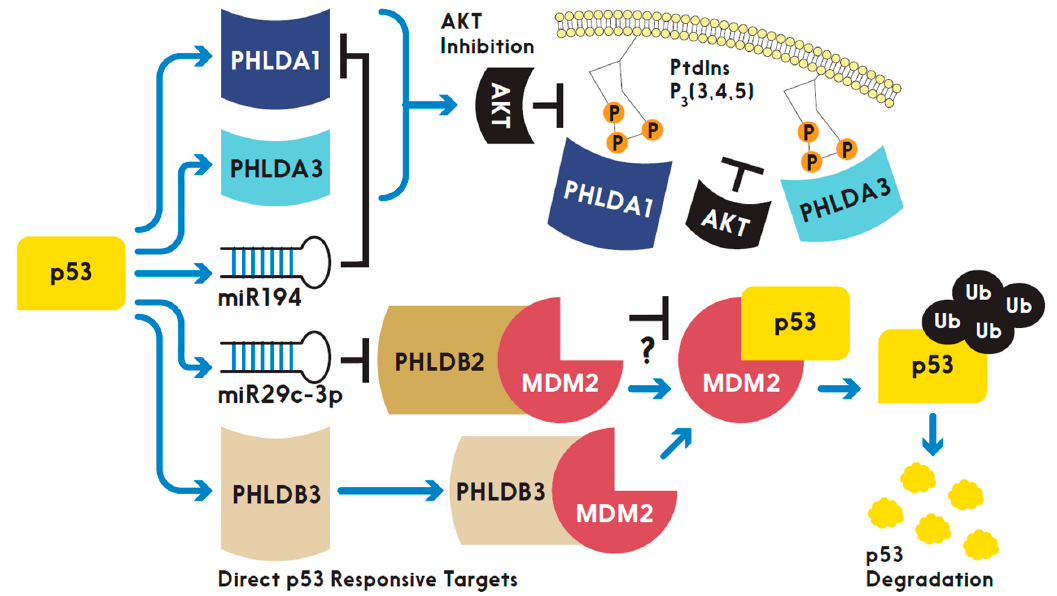
Figure 2. A schematic depicting the interplay between p53 and the PHLD class proteins in regulation of cell signaling. “T” shaped bars indicate “inhibition” while arrows denote “activation” or “promotion” and “?” suggests “unknown”.